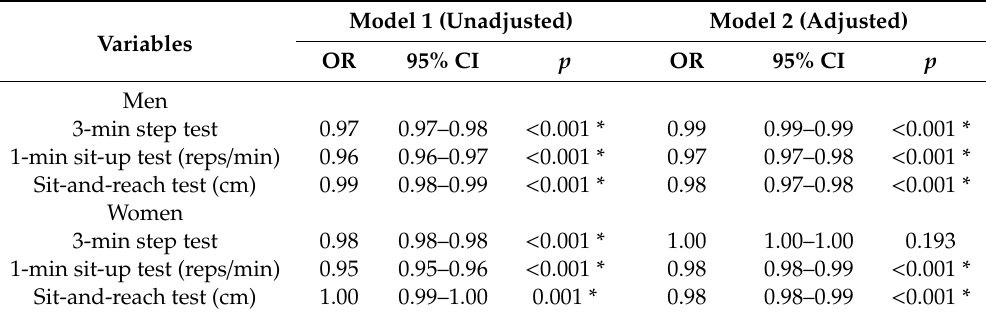
Table 3. Multivariate adjusted ORs for abdominal obesity in relation to health-related physical fitness measurements after adjustment for potential